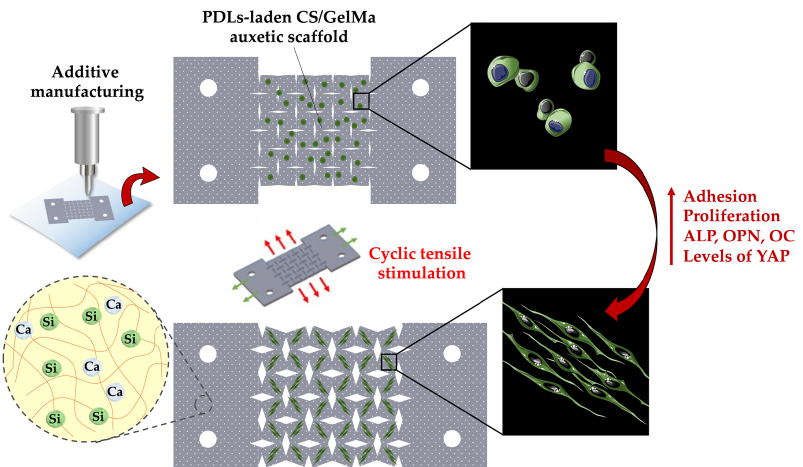
Figure 1. Schematic diagram of the 3D printed CS/FGelMa auxetic scaffold using the proposed structural design, which endowed the scaffolds with the ability to activate the YAP protein by the cyclic tensile stimulation and also enhanced osteogenic-related protein expression.